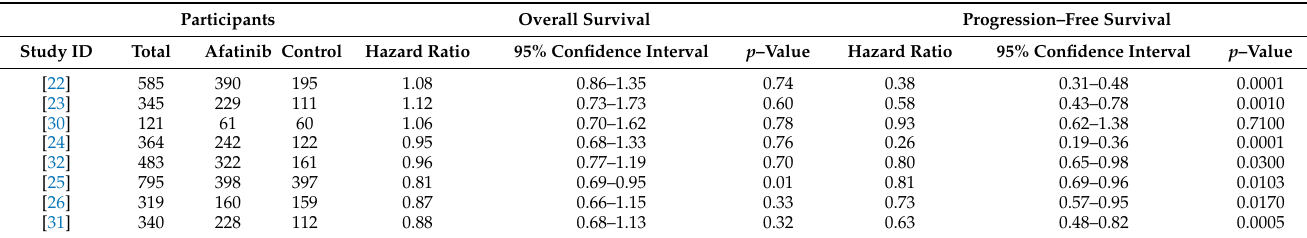
Table A2. The extracted hazards ratios of Progression-free survival and overall survival to proceed